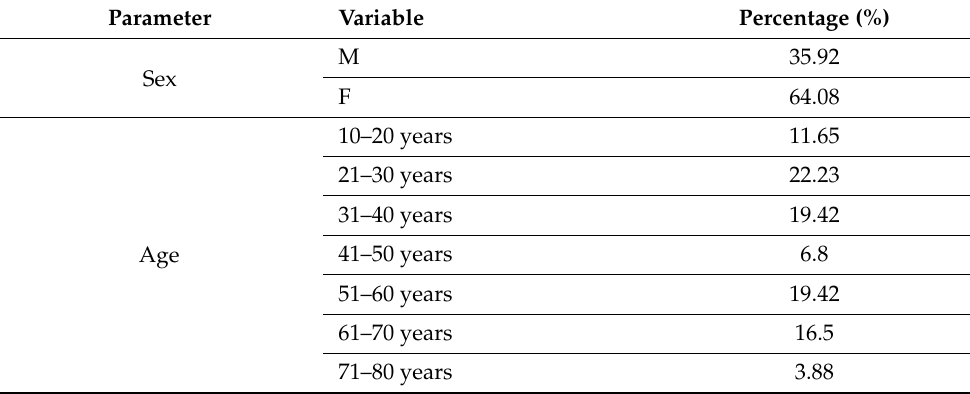
Table 2. Breakdown of patients according to sex and age.